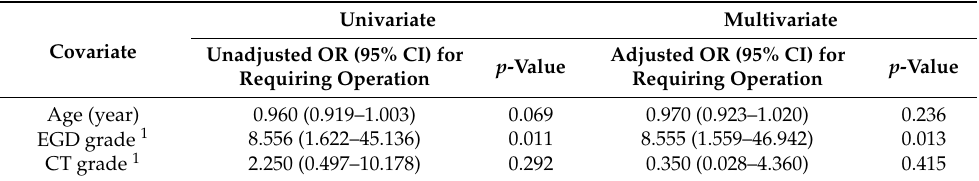
Table 3. Logistic regression models for patients in group C2 (requiring operation) and group C3 (not requiring operation).